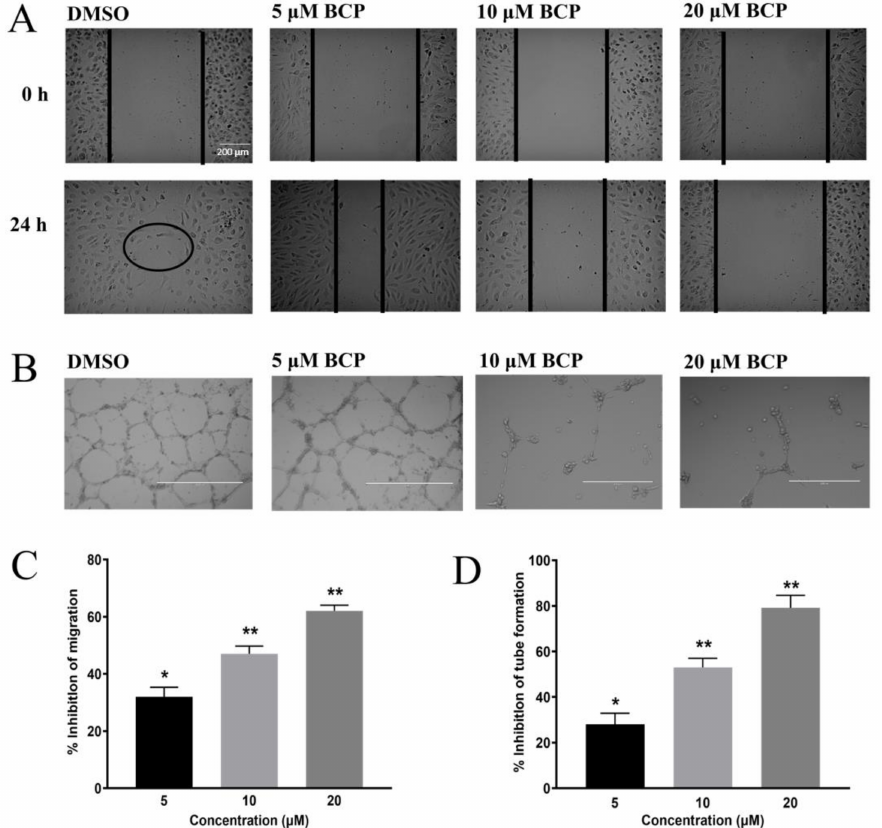
Figure 1. BCP inhibited angiogenesis in vitro. Photomicrographs of scratch assay ( A ) and tube formation assay ( B ) after treatment of 0.5% DMSO, 5, 10, and 20 µ M BCP with HUVECs for 24 h. The circle in ( A ) indicates the closure of the wound on the DMSO group at 24 h. The images were captured by an inverted phase-contrast microscope with the scale indicating 200 µ m. The concentration-dependent effect of BCP on cell migration assay. Data were represented as mean ± SD ( n = 3). * p < 0.05 and ** p < 0.01 compared to DMSO-treated control group ( C ). The concentration- dependent effect of BCP on tube formation assay. Data was represented as mean ± SD ( n = 3), * p < 0.05 and ** p < 0.01 compared to DMSO-treated control group ( D ).